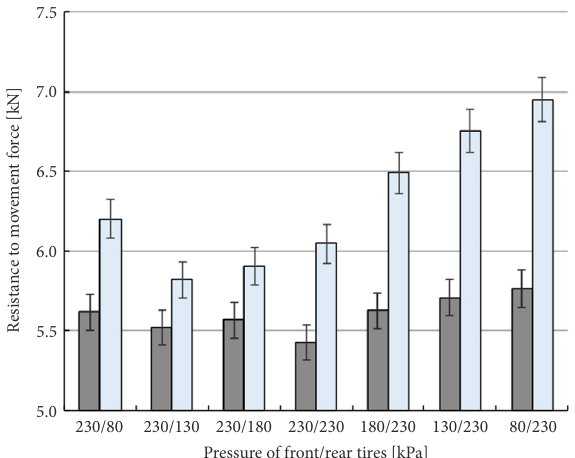
Figure 5. Forces of tractor resistance to motion, when tractor was pulled at a speed of 1.39 m/s at different front and rear tire pressures: dark-coloured columns – 2WD mode; light-coloured columns – 4WD mode